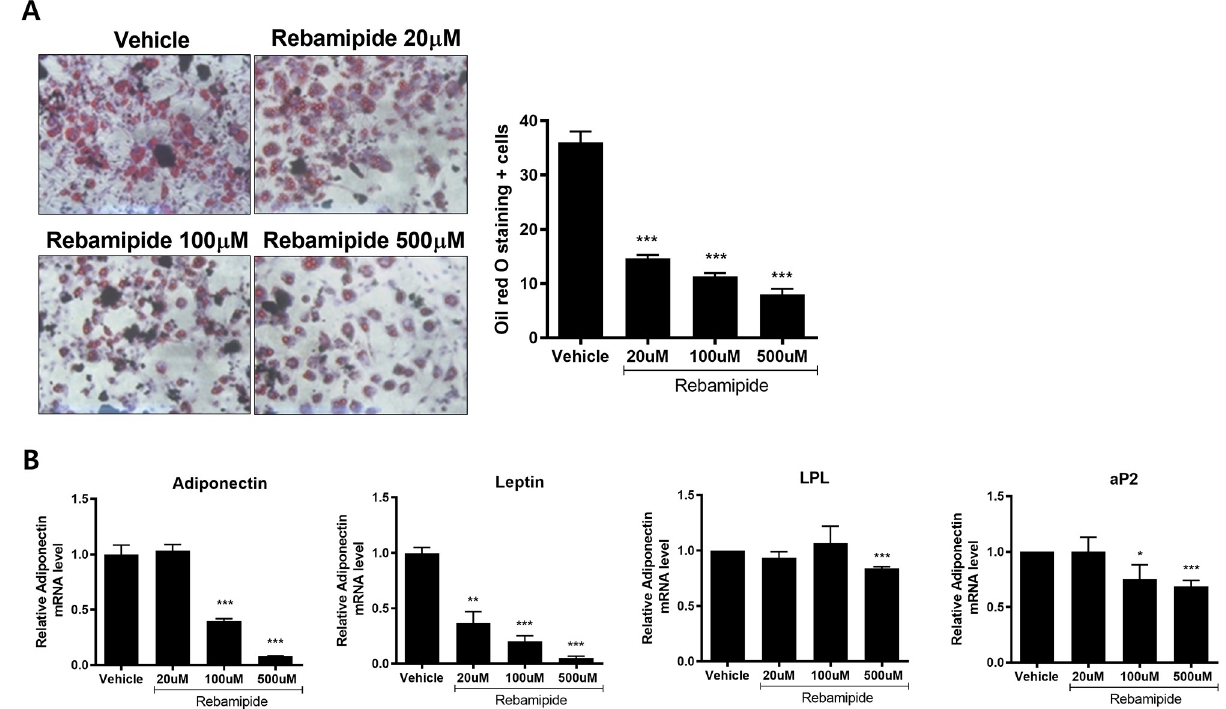
Fig 5. Rebamipide inhibits adipogenesis in vitro . (A) Adipocyte differentiation of 3T3-L1 was inhibited by rebamipide. (B) Expression of adipogenesis-related genes such as adiponectin, leptin, lipoprotein lipase (LPL) and adipocyte protein 2 (aP2) measured by qPCR. � P < 0.05, �� P < 0.01 and ��� P <